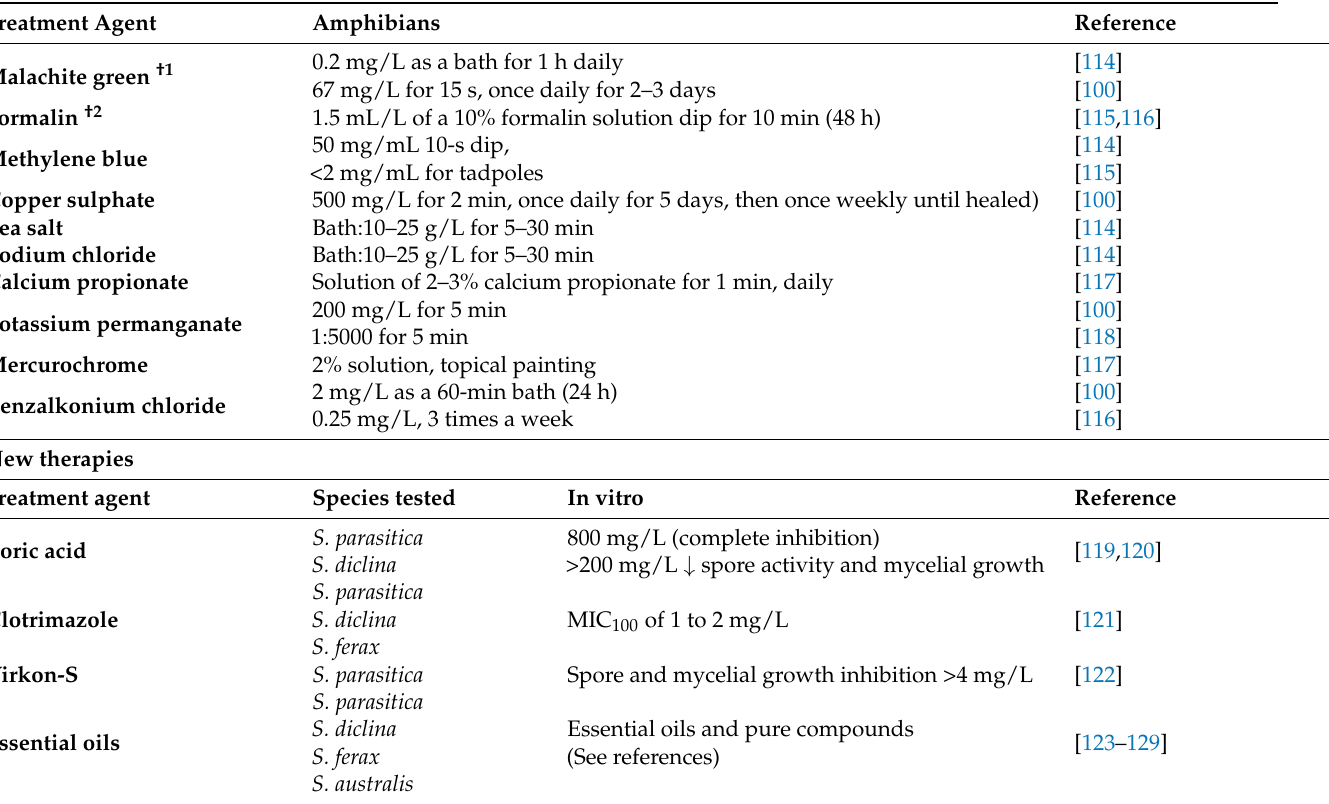
Table 2. Summary table of published works on compounds that are used to treat saprolegniosis in amphibians, not considering the pathogen agent specifically. Potential new treatments tested in vitro, though not yet in use, are also reported. Note: The following table is shown for informational purposes only, and any treatment requirements should not be determined without the consultation of a specialized